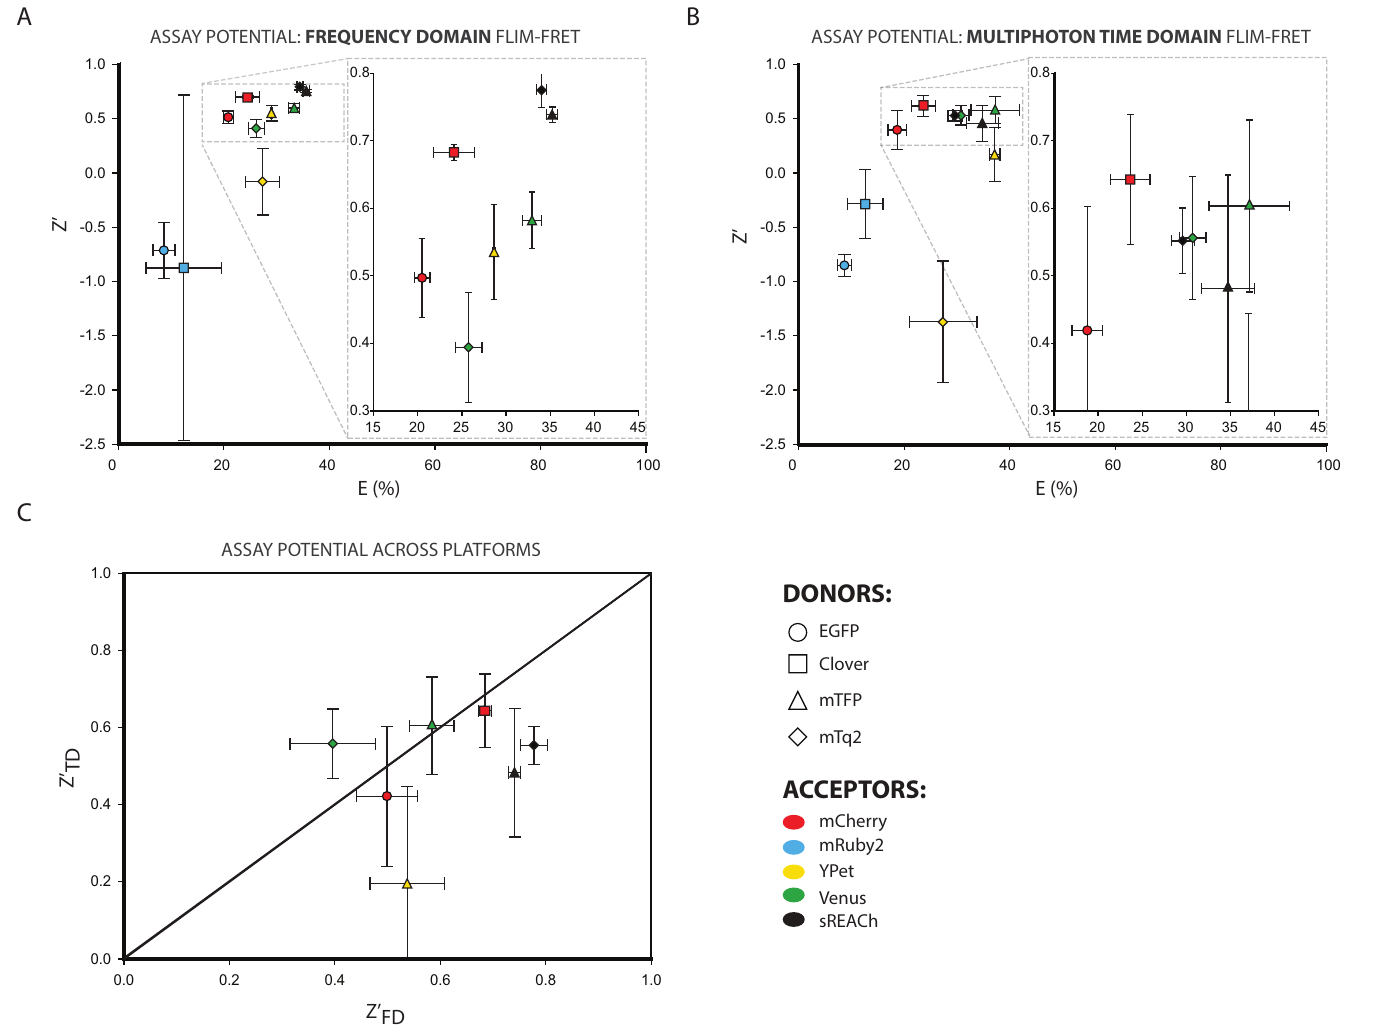
Fig 6. Z-Factor and FRET efficiency as a measure of the dynamic assay potential of FRET pairs expressed in mammalian cells. Throughout this figure the donor involved is denoted by the shape of the point (EGFP = circle, Clv = square, mTFP = triangle and mTq2 = diamond) and the acceptor is denoted by the fill-colour of the symbol (mCh = red, mR2 = blue, YPet = yellow, Ven = green and sRCh = black) A. Plot of the mean Z’ of the frequency domain lifetime measurements over a 10 minute time course in 3 separate experiments against their mean FRET Efficiency for those experiments. Error bars on both axes represent standard deviation. B. Plot of the mean Z’ of the multiphoton time domain lifetime measurements over a 10 minute time course in 3 separate experiments against their mean FRET Efficiency for those experiments. Error bars on both axes represent standard deviation. C. Direct comparison of the Z’ values from the two different FLIM systems; pairs that respond similarly on both systems will fall on the x = y diagonal. Error bars represent standard